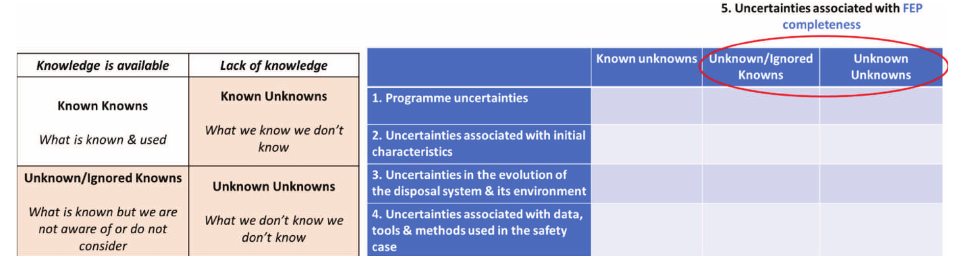
Fig. 4. Classification of uncertainties according to the availability and use of associated knowledge (left) and the uncertainty matrix combining specific uncertainties types with availability of knowledge (right).